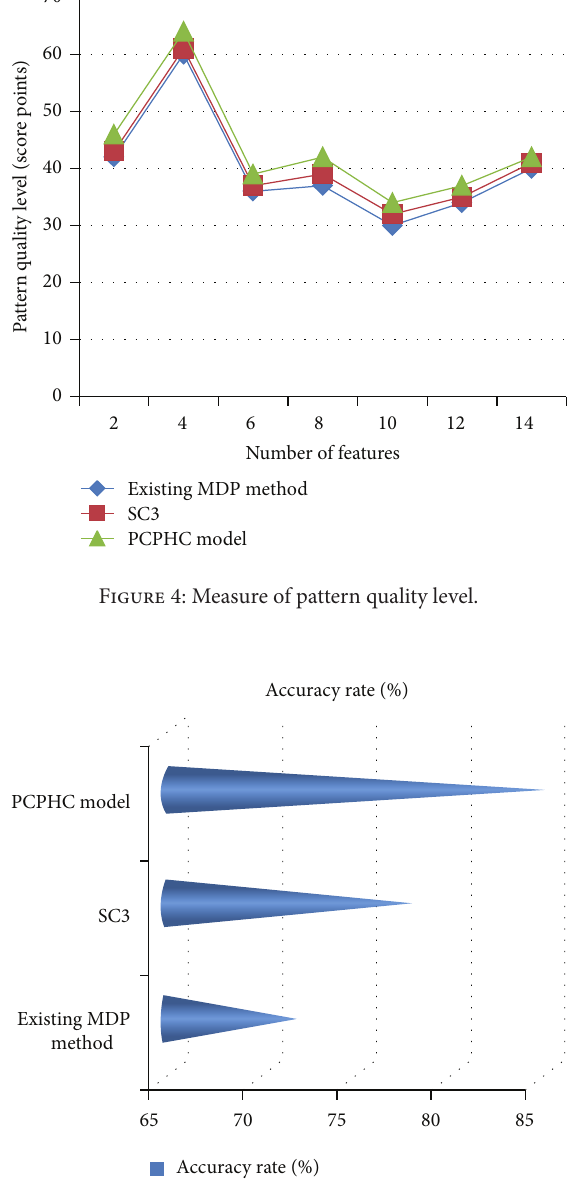
Figure 5: Technique versus accuracy rate (using GenBank data- base).